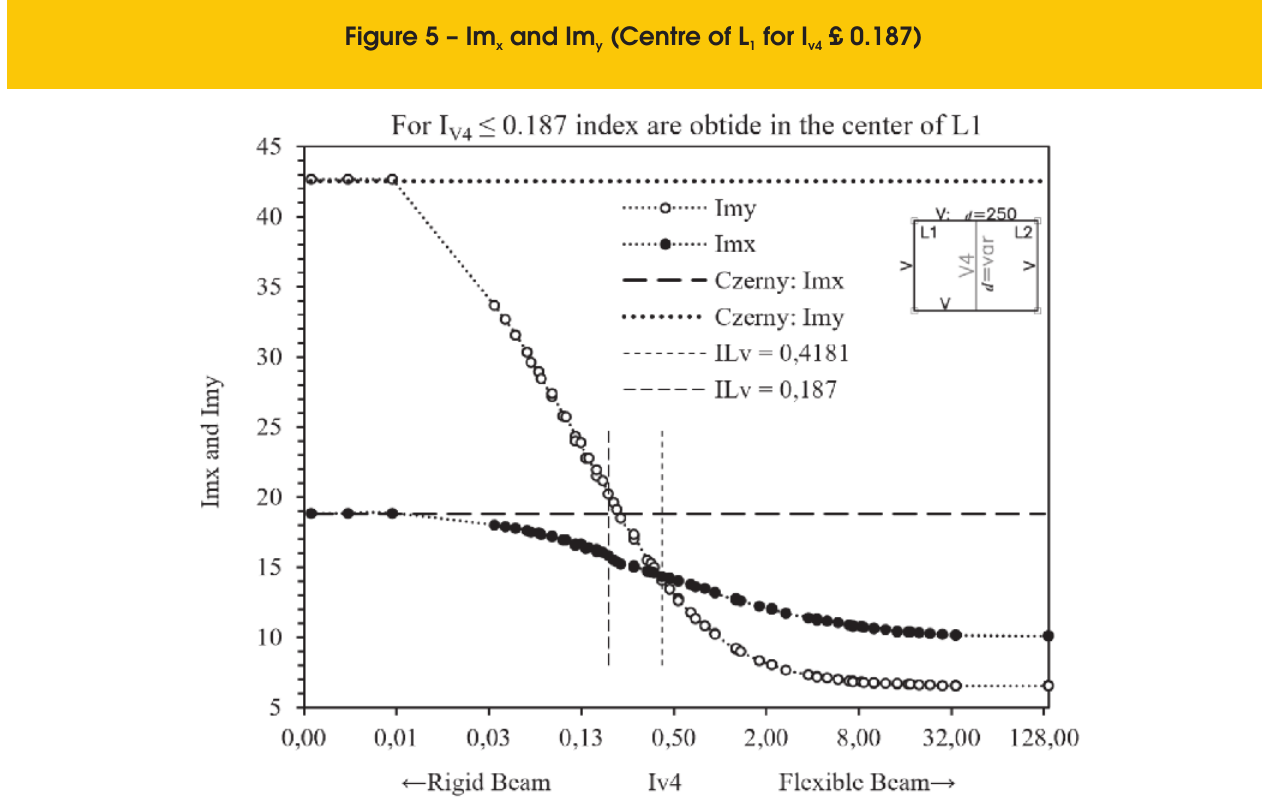
Figure 5 – Im and Im (Centre of L for I £ 0.187)